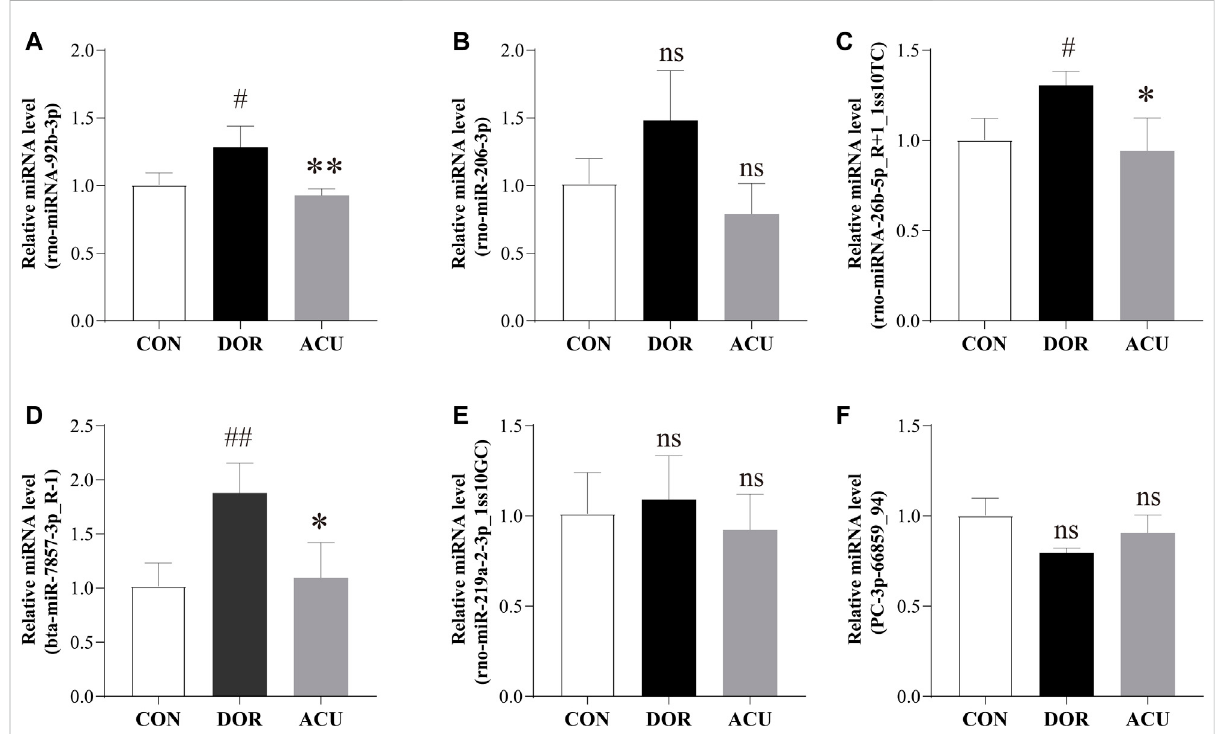
Detection of selected differentially expressed miRNAs. Expressions of (A) rno-miR-92b-3p, (B) rno-miR-206-3p, (C) mdo-miR-26b- 5p_R+1_1ss10TC, (D) bta-miR-7857-3p_R-1, (E) rno-miR-219a-2-3p_1ss10GC, and (F) PC-3p-66859_94 were determined in the ovaries of CON, DOR, and ACU groups by RT-qPCR. Data are presented as mean ± standard deviation (SD). Compared with CON, ## p < 0.01, # p < 0.05; compared with DOR, ** p < 0.01, * p < 0.05; not signi fi cant, ns; n = 3. CON, control group; DOR, diminished ovarian reserve; ACU, acupuncture